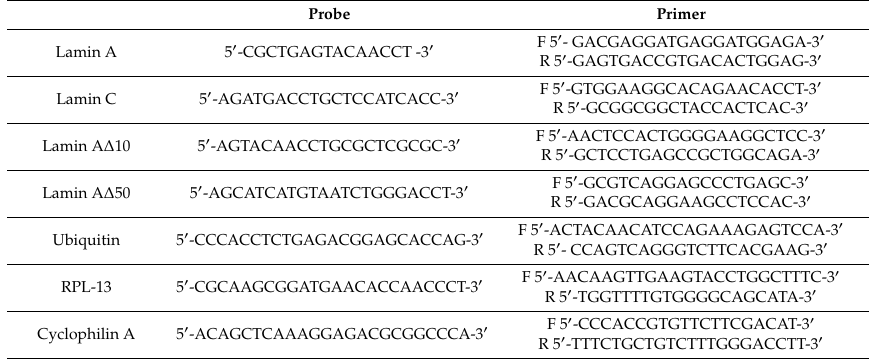
Table 7. Primer / probe sequences used for